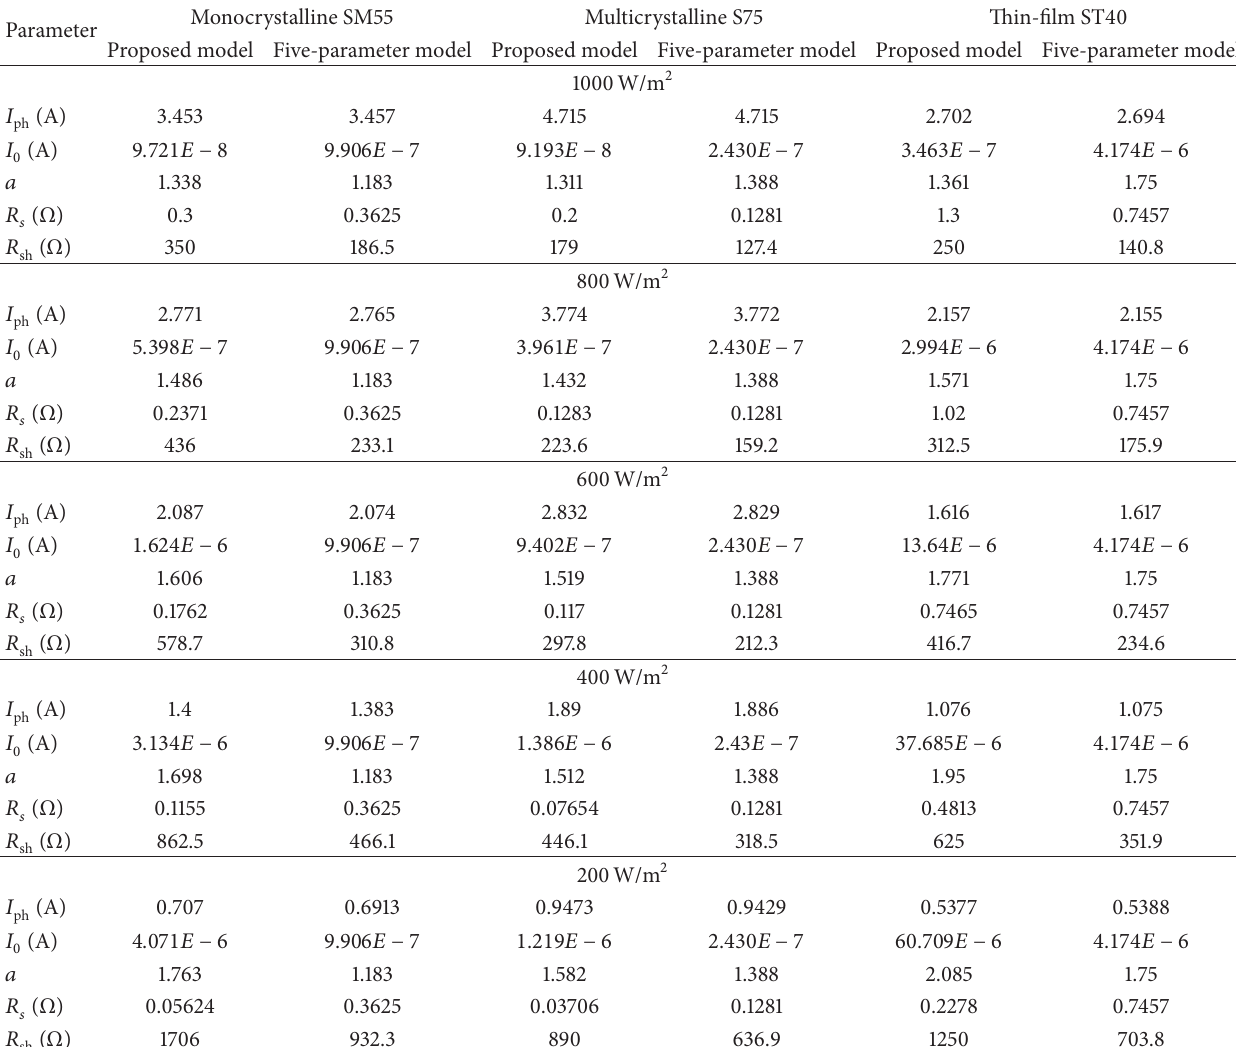
Table 3: Parameters for the proposed